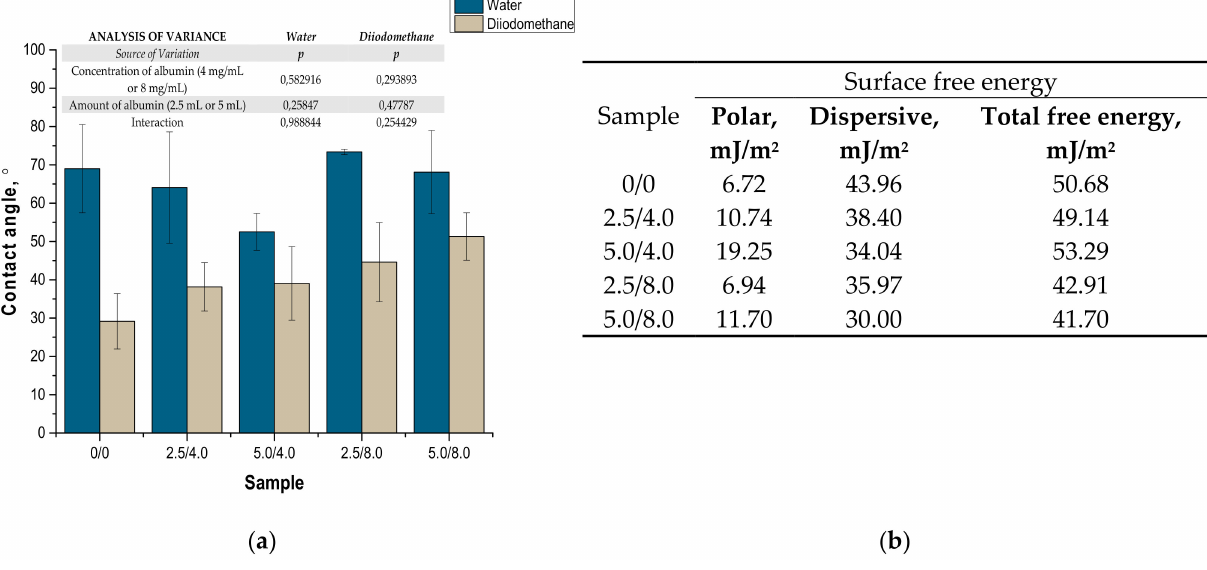
Figure 11. Values of contact angles ( a ) (n—number of repetitions, n = 3; p indicates the statistical significance calculated using the two-way analysis of variance (ANOVA)) and surface free energies determined for tested hydrogels ( b